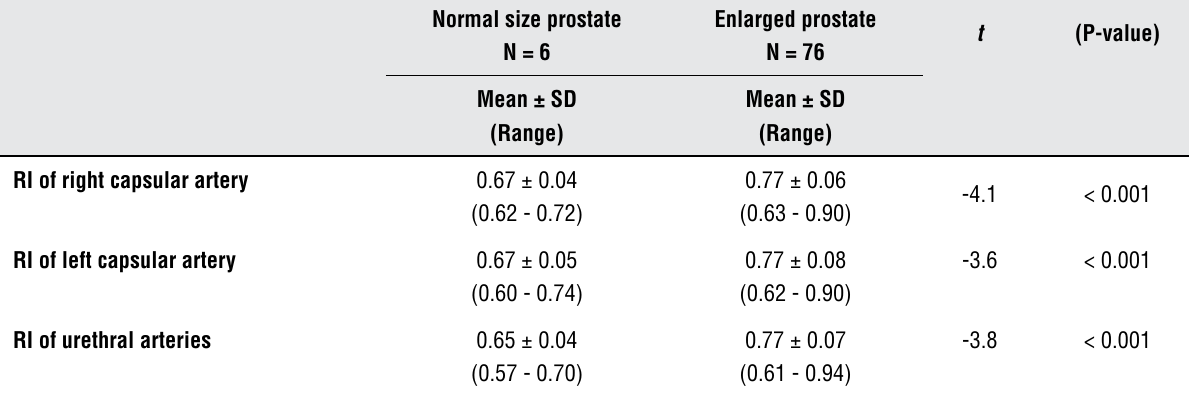
Table 4 - Comparison of parameters between patients with a normal prostate size and those with enlarged